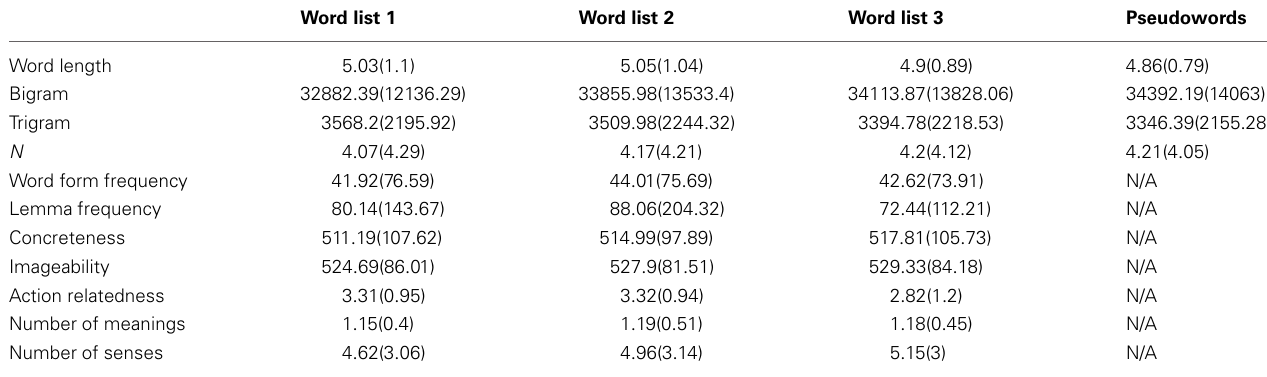
Table 1 | Mean values (and standard deviations) of 11 psycholinguistic variables for the three word lists and one pseudoword